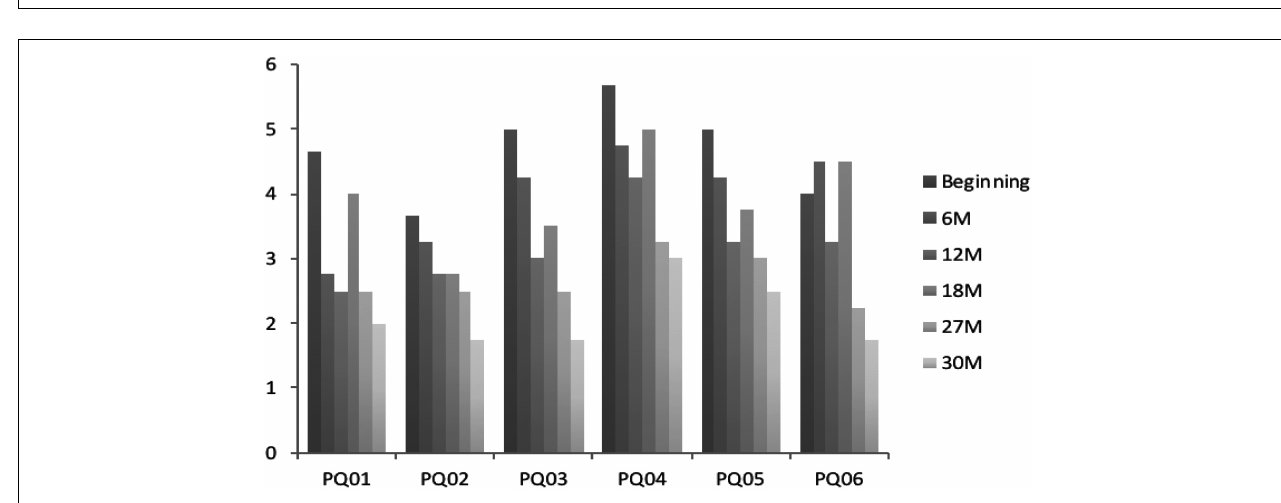
FIGURE 5 | John’s SAI-R scores and Portuguese men mean. M, months in treatment.